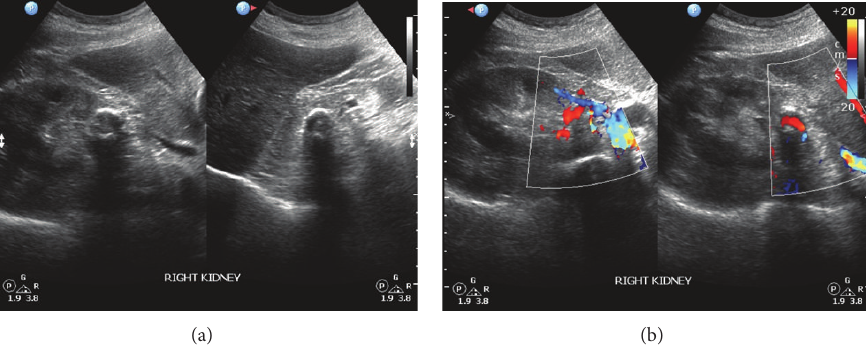
Figure 1: (a) This grey-scale transabdominal ultrasonography image of the right renal area was acquired with a curvilinear multifrequency transducer. It incidentally revealed a curvilinear reflective line with acoustic shadow behind it. This structure was located near the renal pelvis. (b) Color Doppler imaging demonstrated blood flow within the previously described structure. Thus, the structure should be vascular in its nature.